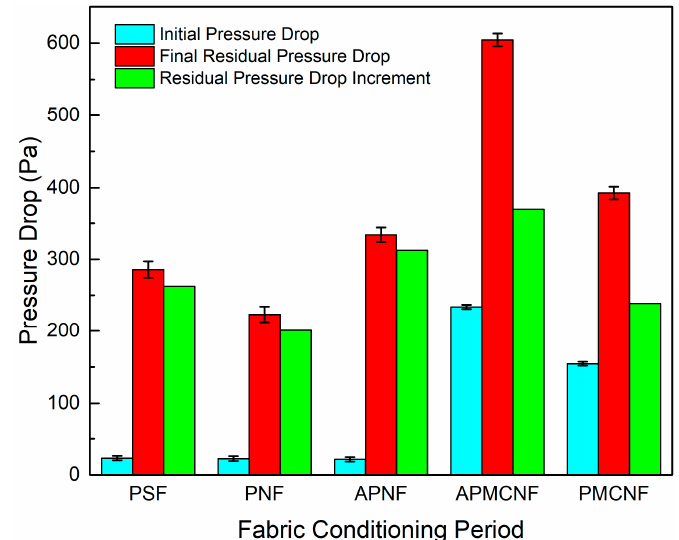
Figure 9. The final residual resistance and the initial residual resistance of the five filter media during the fabric conditioning period.